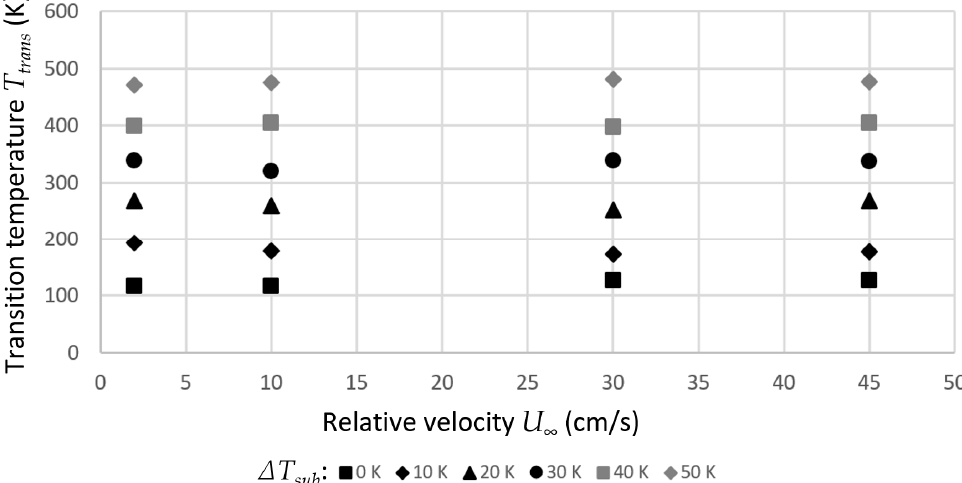
Figure 14. Experimental data for the influence of the relative velocity ( U ∞ , X-axis) on the transition temperature ( T trans , Y-axis) at different subcoolings of the coolant (different symbols in graph) (graph created from numerical values in Reference [83]).